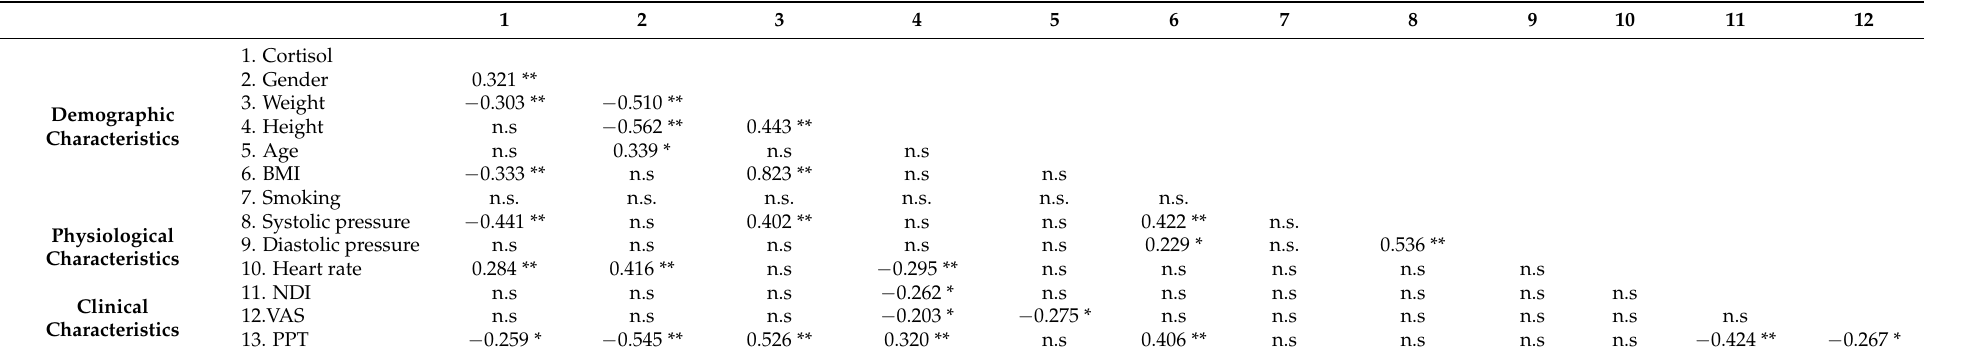
Table 3. Pearson-product moment correlation matrix: cortisol, demographic, clinical and physiological